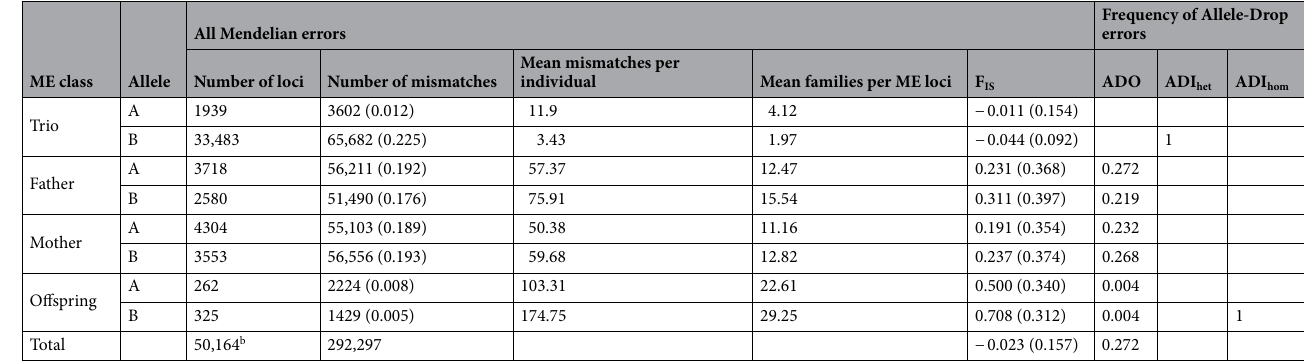
Table 2. ME frequency according to the eight ME classes defined. The following information is given: number of loci having mismatches in each error class, number of mismatches (proportion of the total mismatches identified in brackets), mean number of mismatches per both individual and family, and mean F IS (± standard deviation). Note that 4604 loci had mismatches assigned to two or more ME classes (see Fig. 4). Furthermore, the frequencies of Allele Drop-Out (ADO; 388 loci and 75,843 mismatches) and Allele Drop-In identified on heterozygotes (ADI het ; 3447 loci and 5397 mismatches) or homozygotes (ADI hom ; 17 loci and 37 mismatches) per error class are also given.